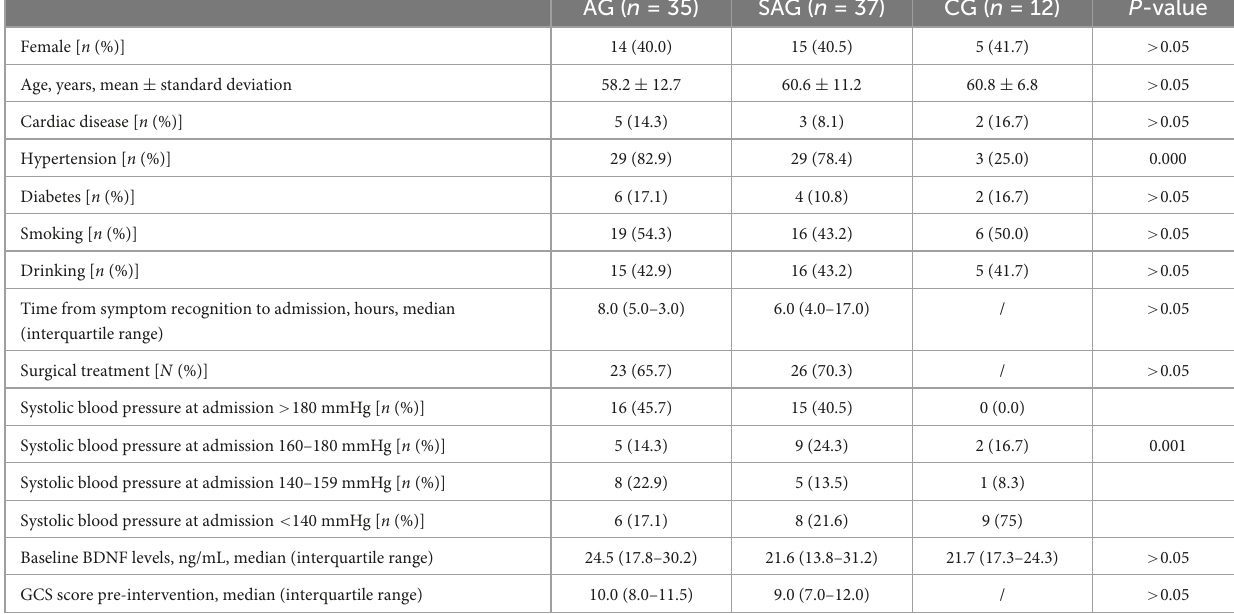
TABLE 2 Baseline characteristics.